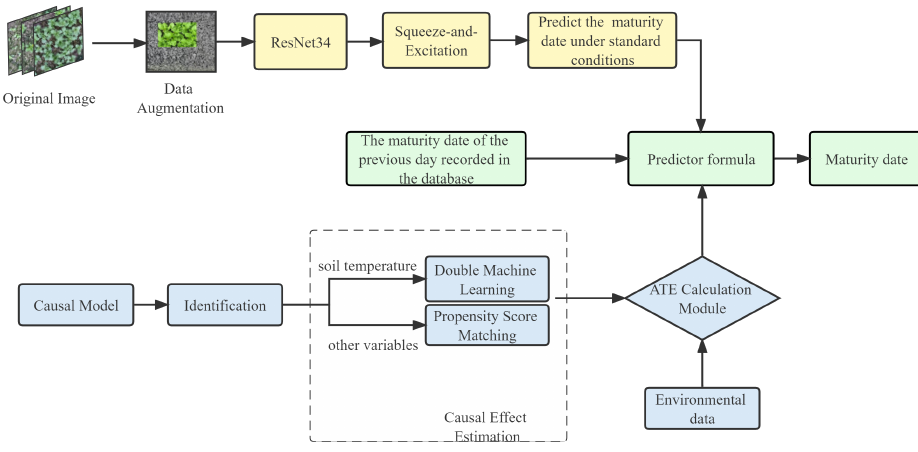
Figure 7. Block diagram of the proposed prediction